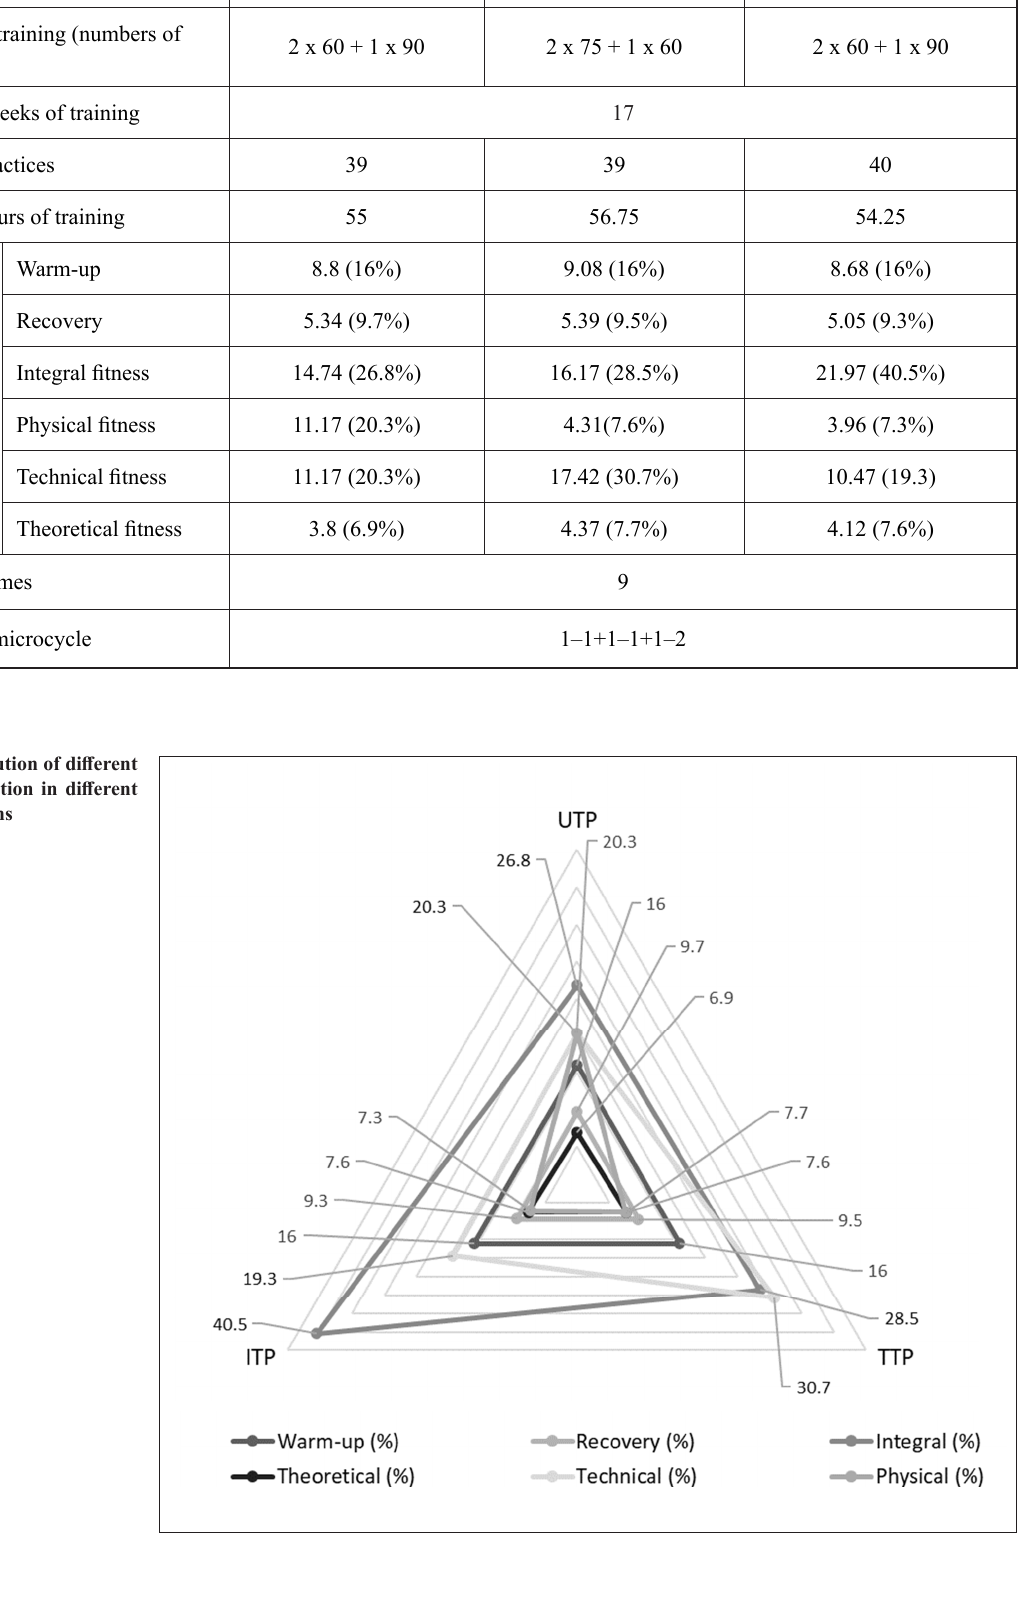
Table 2. Regulatory part of training programs for mini-basketball players (8–9 years of age)